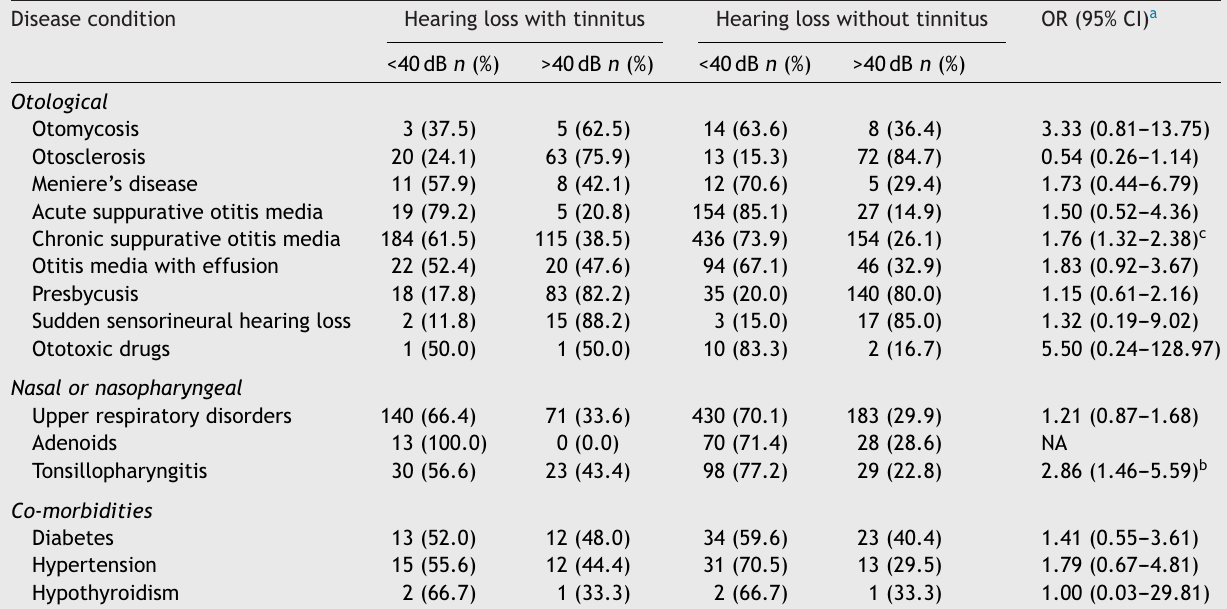
Degree of hearing loss in subjects with and without tinnitus in otological disorders. Disease condition Hearing loss with